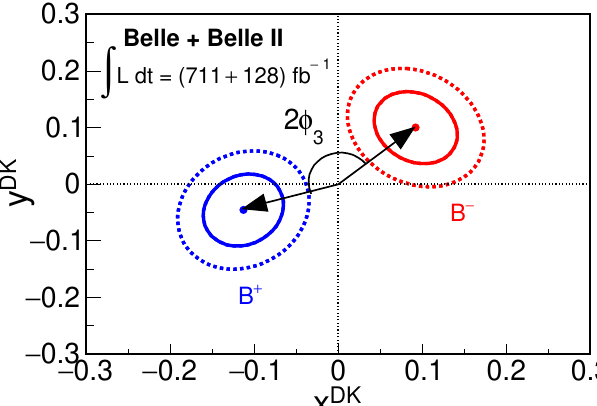
Figure 8 . Two-dimensional confidence regions at (inner curve) 68.3% and (outer curve) 95.5% (cid:1) (blue) and (cid:0) (cid:1) (red) as measured in probability for (cid:0) x DK , y DK , y DK x DK + + − − a profile likelihood scan. The dots represent central